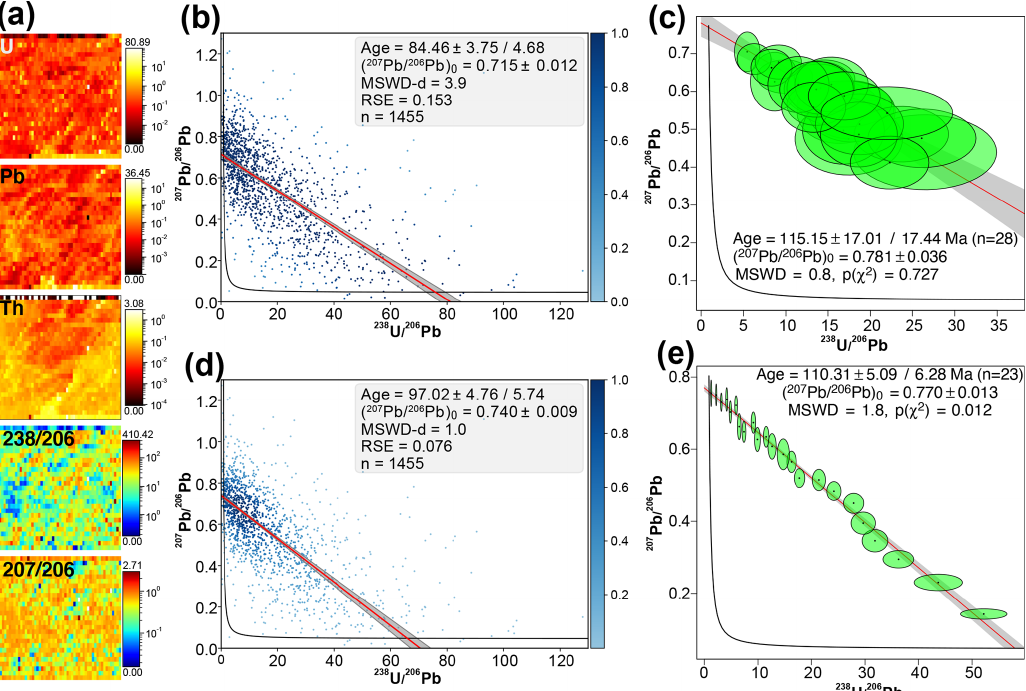
Figure 9. Results obtained for sample C6-265-D5. (a) Semi-quantitative element concentrations in parts per million (U, Pb and Th) and 238 U / 206 Pb– 207 Pb / 206 Pb isotopic maps. (b) TW concordia plot with ages and their uncertainty calculated by robust regression. Pixels with 238 U / 206 Pb and 207 Pb / 206 Pb values above 130 and 1.3 respectively are not shown ( n = 13). (c) TW concordia plot calculated from discretisation of the isotopic map (pseudo-spots). (d) TW concordia plots calculated by weighted robust regression, with pixel weights calculated from a 2D kernel density estimate. (e) TW concordia plot obtained with the approach of Drost et al.